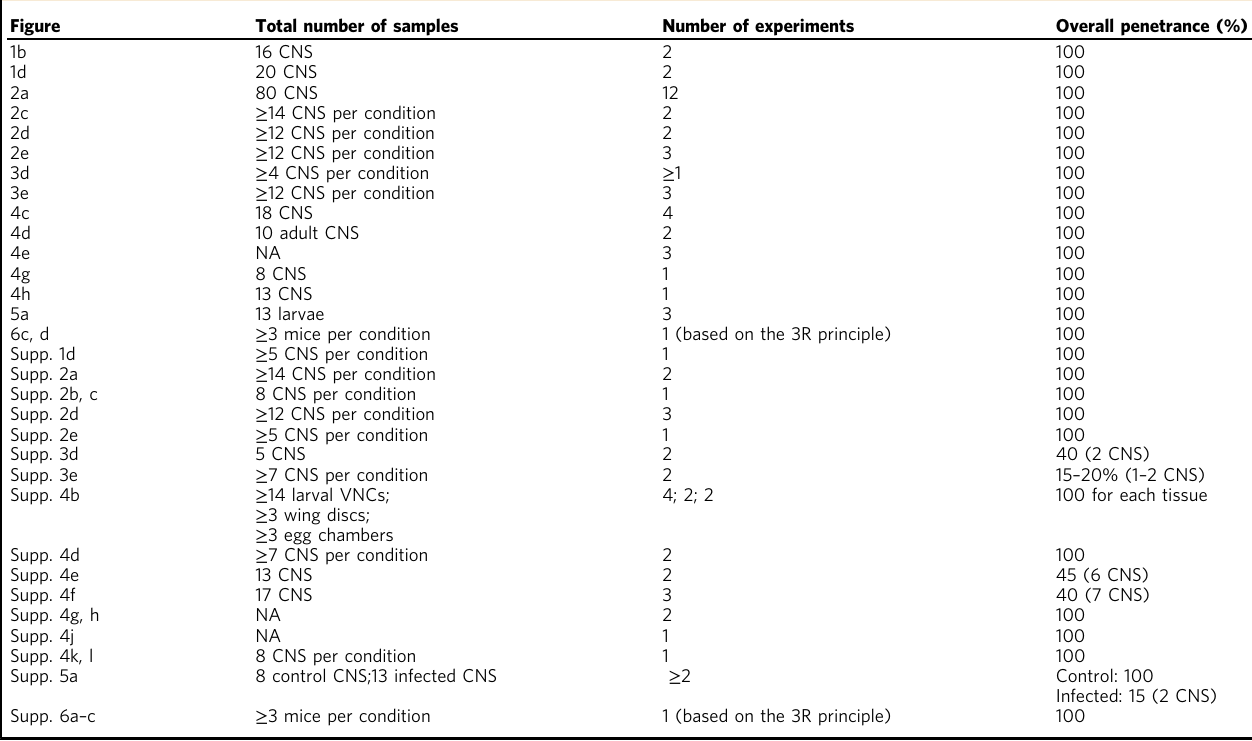
Table 3 Experimental reproducibility. Figure Total number of